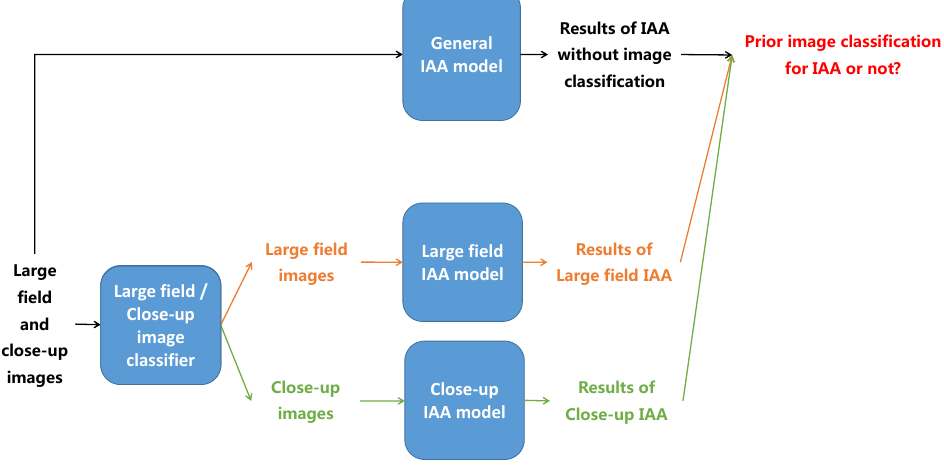
Figure 2. The process of image aesthetic study based on LCIC